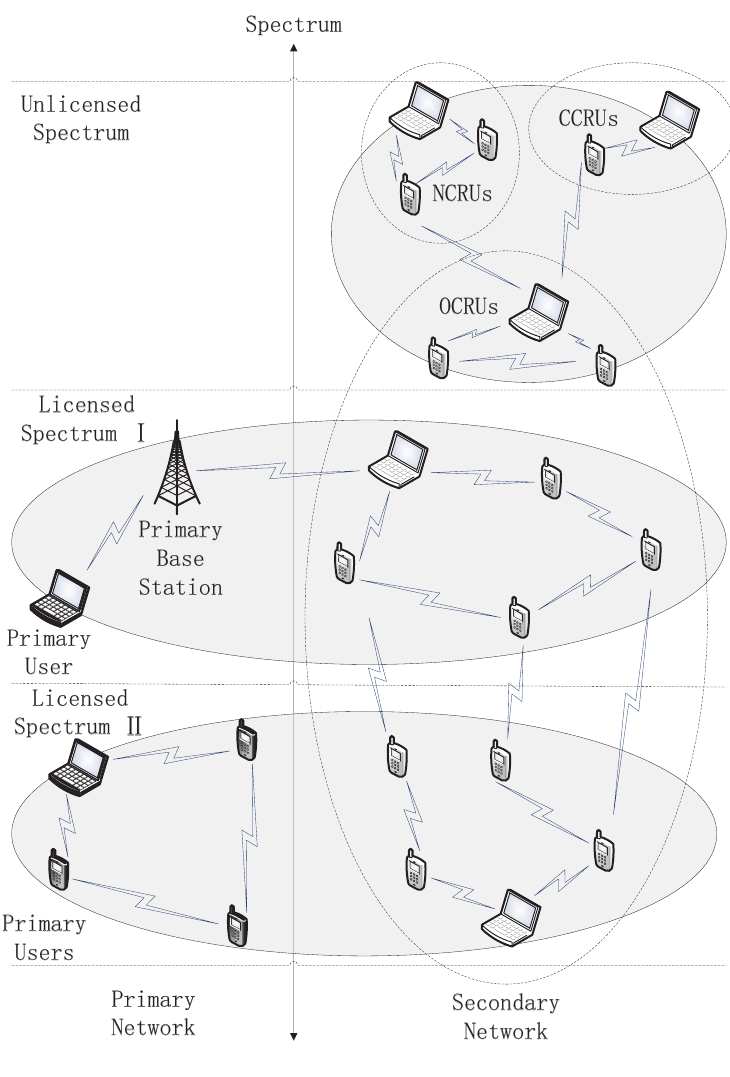
Figure 3. System Architecture of